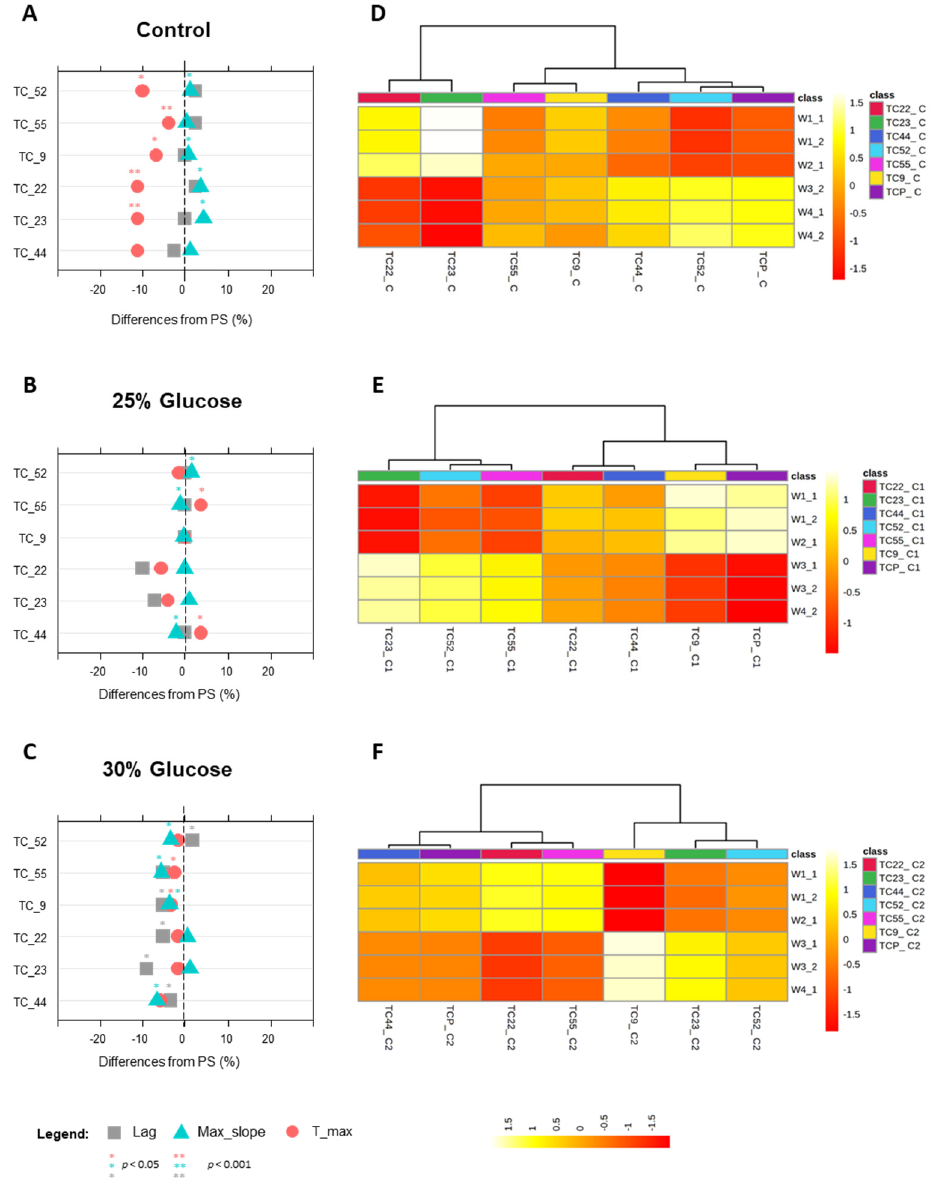
Figure 6. Growth and metabolomic phenotypes of S. cerevisiae TC1517 strain and its derived MSCs during growth at increasing concentrations of glucose (25–30%, w / v ). Panels ( A – C ): Lag time (grey square), max_slope (light blue triangle) and t_max (light red circle) parameters reported as percentage difference respect to the parental strain. Panels ( D – F ): Heatmap of the significantly altered FTIR peaks (distance measure using Euclidean, and clustering algorithm using ward.D). The coloured boxes indicate the relative intensities of the mean of peaks in the corresponding spectral region. The colour scale is log2 transformed value and indicates relatively high (yellow) and low (red) peak intensities. Spectral regions have been divided into sub-regions, namely: Fatty acids (W1_1 from 3200 to 3100 cm − 1 –W1_2 from 3098 to 2801 cm − 1 ); Amides (W2_1 from 1800 to1649 cm − 1 –W2_2 from 1647 to 1501 cm − 1 ); Mixed region (W3_1 from 1499 to 1352 cm − 1 –W3_2 from 1350 to 1202 cm − 1 ); Carbohydrates (W4_1 from 1200 to 1053 cm − 1 –W4_2 from 1051 to 902 cm − 1 ).